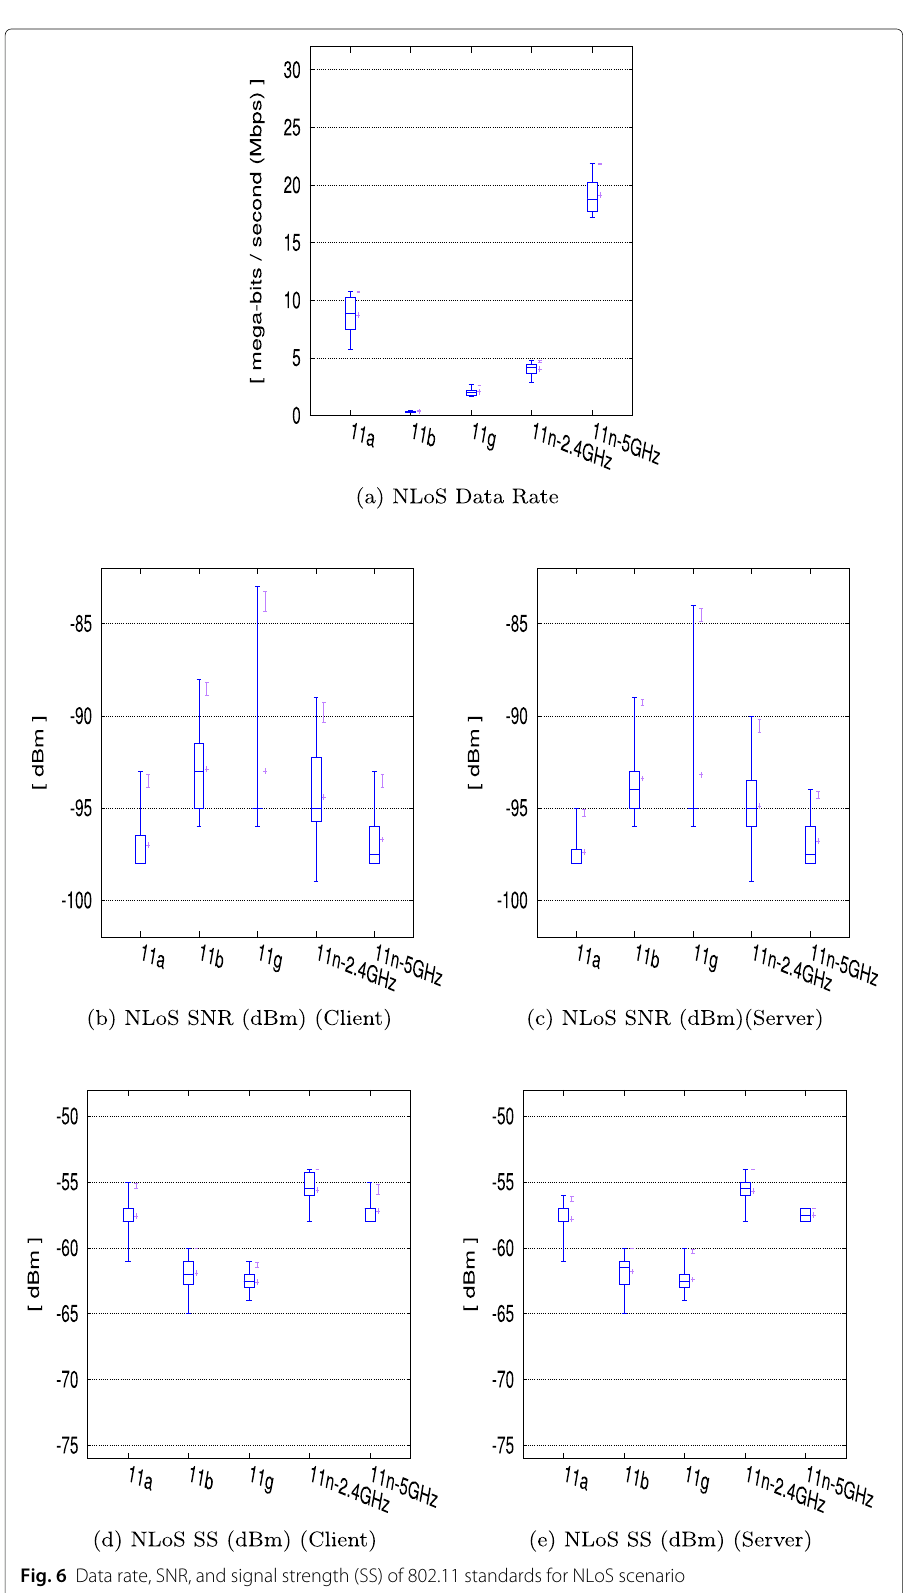
Fig. 6 Data rate, SNR, and signal strength (SS) of 802.11 standards for NLoS